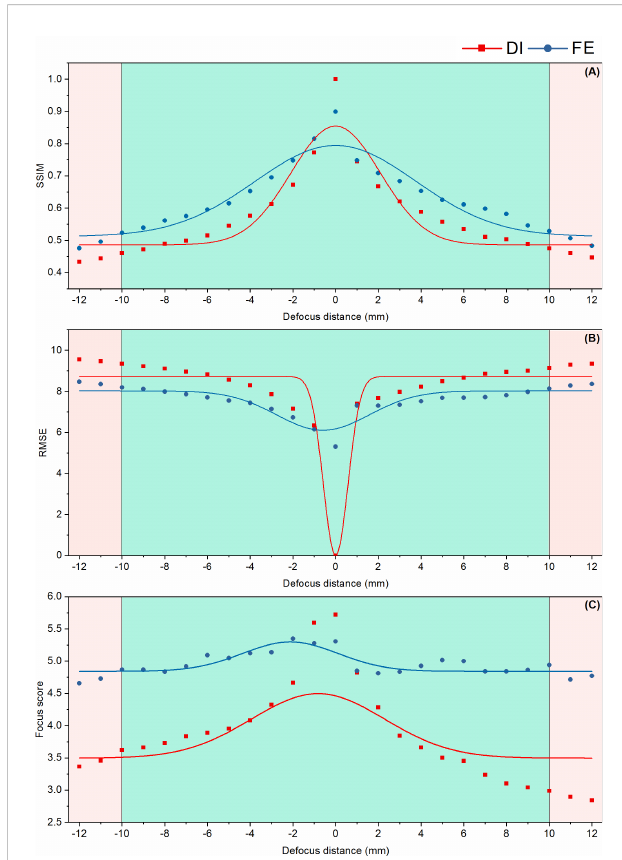
FIGURE 9 Quantitative focus-extension evaluation of the IsPlanktonFE network using a 2mm SiO 2 bead by the metrics of SSIM (A) , RMSE (B) and focus score (C) , respectively. The cyan areas in the panels indicate a defocus distance range from which the recorded SiO 2 bead images are used for training the IsPlanktonFE model. The pink areas indicate defocus distance ranges where the recorded SiO 2 bead images were NOT used to train the IsPlanktonFE